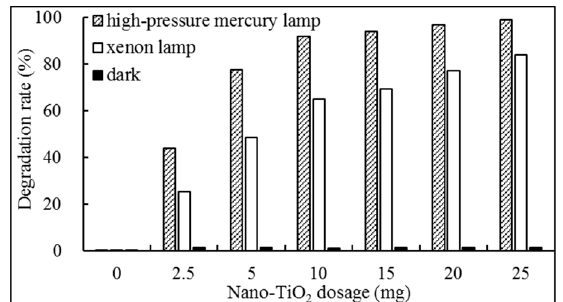
Figure 2. Effect of nano-TiO 2 on photodegradation rate of FPB under the illumination of different light Figure 2. E ff ect of nano-TiO 2 on photodegradation rate of FPB under the illumination of di ff erent source. light source.